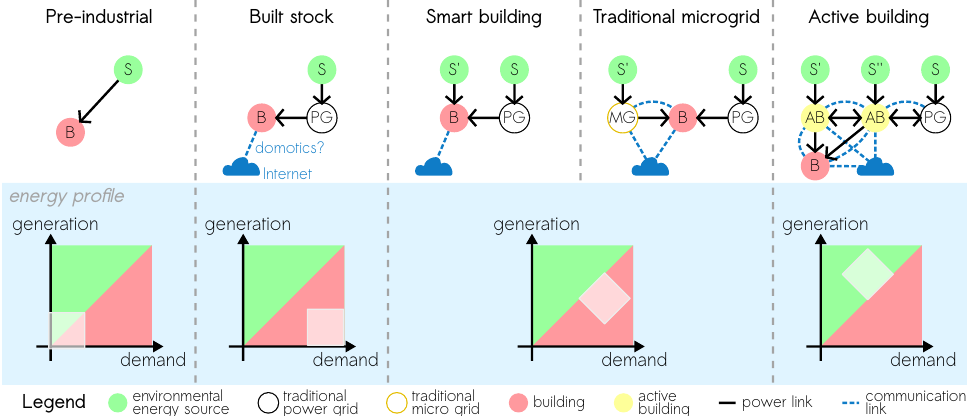
Figure 1. Active buildings have a different energy profile; they also exchange power with other entities, and the corresponding handshake to establish all the parameters of the energy transfer requires additional communications. Adapted from Fosas et al.